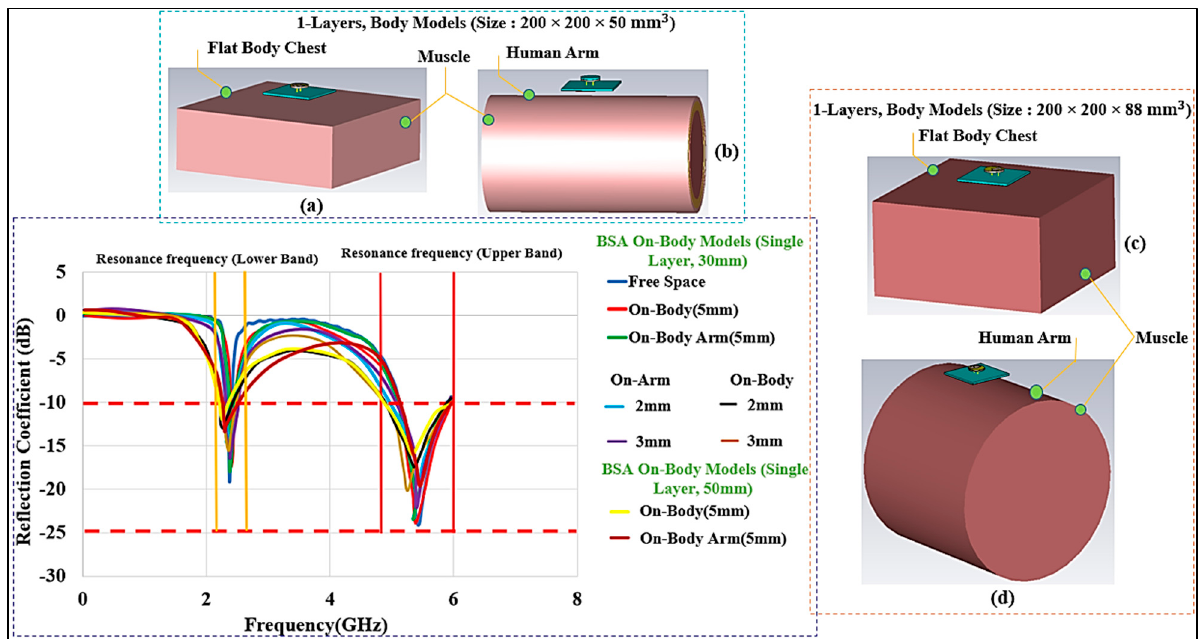
Figure 12. S 11 for BSA. ( a , c ) Homogeneous model ( Muslce (ε (cid:2928) ) = 56.6 and σ = 1.33 S/m, thickness 50 and 88 mm), and ( b , d ) simplified arm models for radius (r) of 50 mm and 100 mm for the small and large size bodies, respectively.